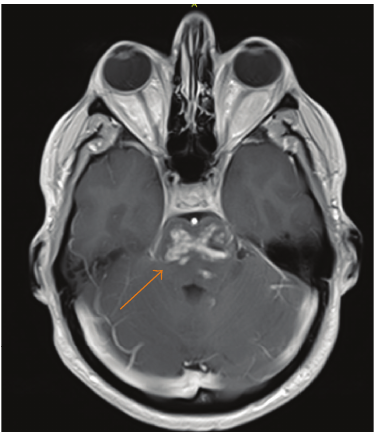
Figure8:A35-year-oldmalewithcontrast-enhancedaxialT1image showing an expansile heterogeneous patchy enhancement within the pons (arrow).